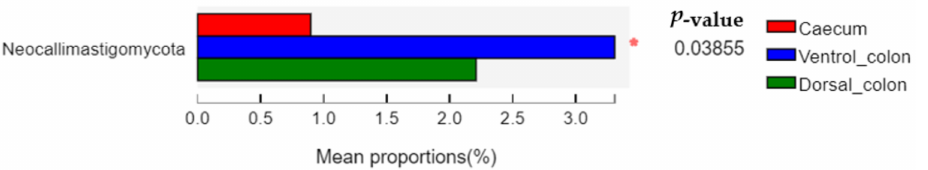
Figure 4. Difference in the relative abundance of fungal phyla (abundance of the phyla was expressed as %). Welch’s two-sided test was used and Welch’s inverted was 0.95. *, p < 0.05.